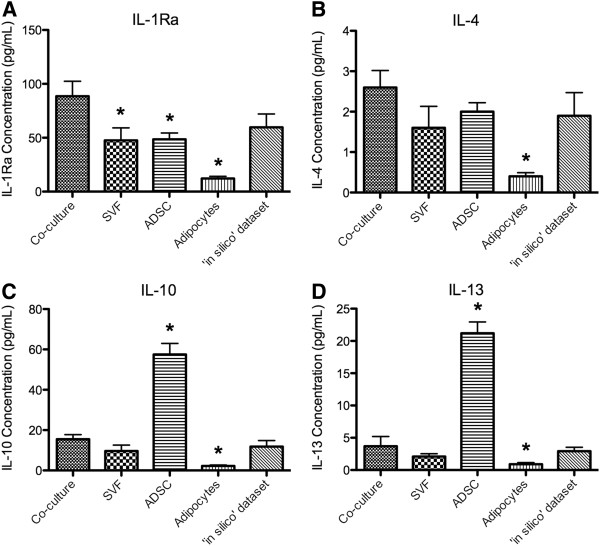
Average concentration of anti-inflammatory cytokines secreted by adipose-derived cell populations. The concentrations of the anti-inflammatory cytokines, IL-1Ra (A), IL-4 (B), IL-10 (C), IL-13 (D), were measured in the conditioned medium of the stromal vascular fraction (SVF) co-cultured with adipocytes (co-culture), SVF, adipose-derived stem cells (ADSC), and adipocytes, as well as the ‘in silico’ dataset. The reported values are the average of 5 biological replicate ± SEM. An * denotes a p-value of ≤ 0.05 when compared to the co-culture dataset.